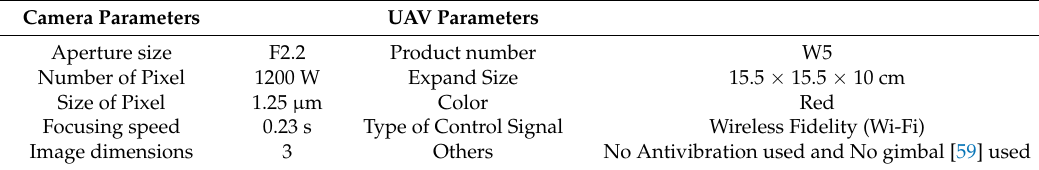
Table 7. The parameters of the tested camera and UAV.